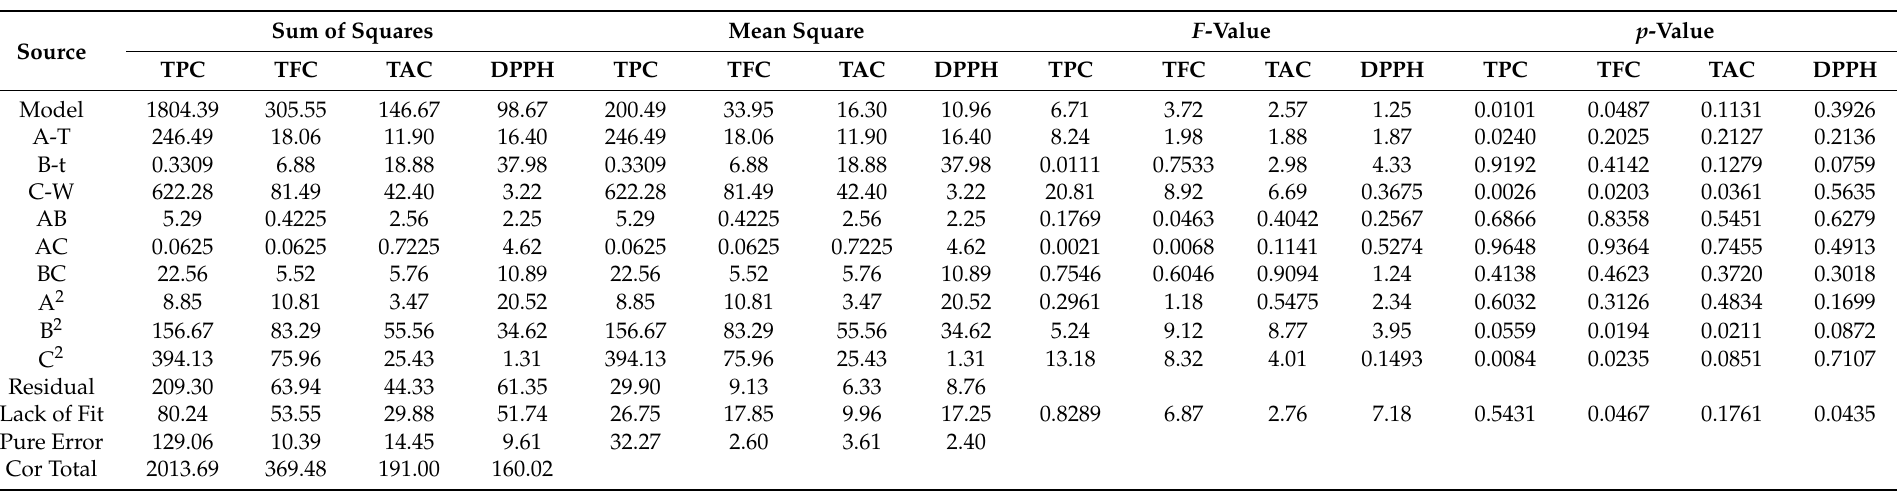
Table 4. Model summary and analysis of variance (ANOVA) of TPC, TFC, TAC, and DPPH of the Chamaenerion angustifolium (L.) Scop. leaf